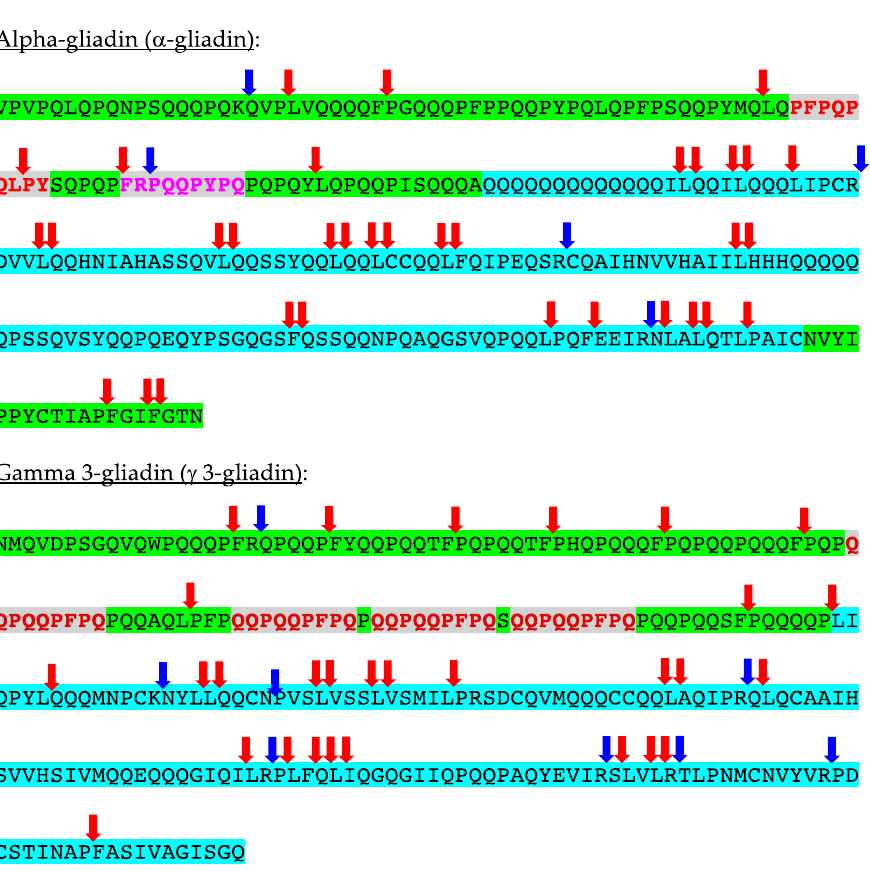
Figure 5. Localization of the putative cleavage sites for pepsin (red arrow) and trypsin (blue arrow) along the amino acid sequences of α -gliadin and γ 3-gliadin predicted with PeptideCutter. The disordered N - and C -terminal regions are colored green, and the C-terminal α -helical core is colored cyan. Potential immunodominant epitopes are in red and magenta letters highlighted in grey.